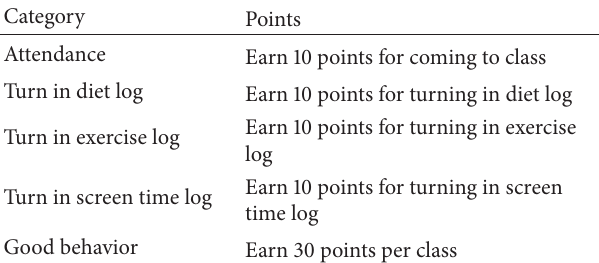
Table 3: Incentive point system for